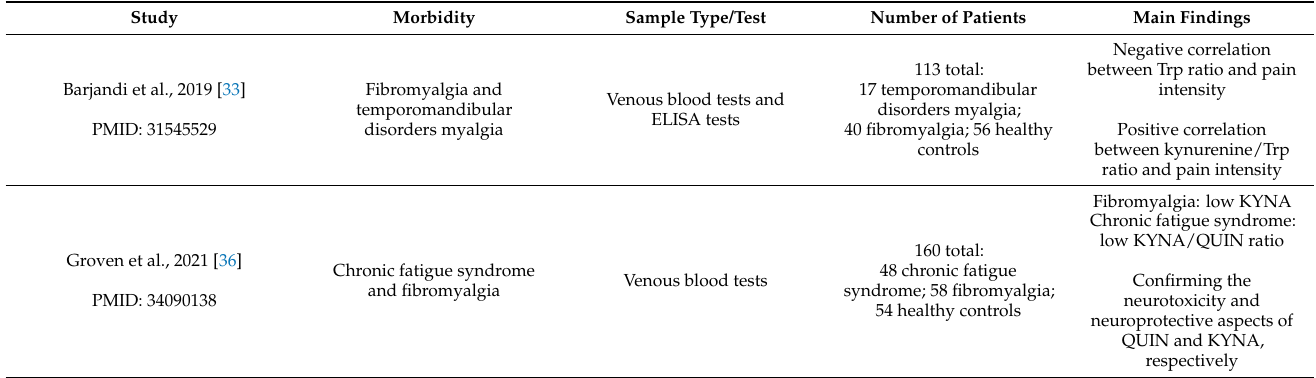
Table 2. Summary of clinical studies investigating the kynurenine pathway metabolites in chronic pain and depression